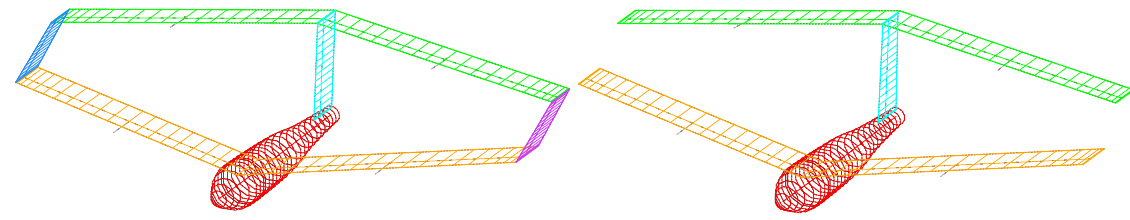
Figure 15. Box-wing ( left ) and tandem-wing ( right ) solar UAVs modelled in